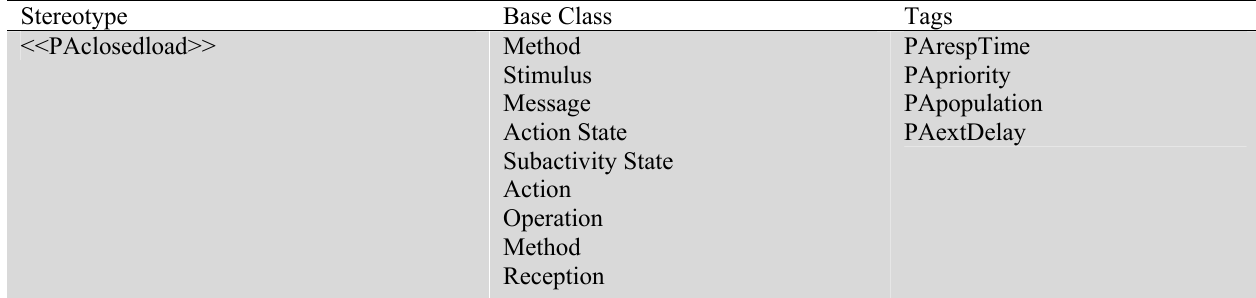
The cliché <<PAcloseload>> with its labels